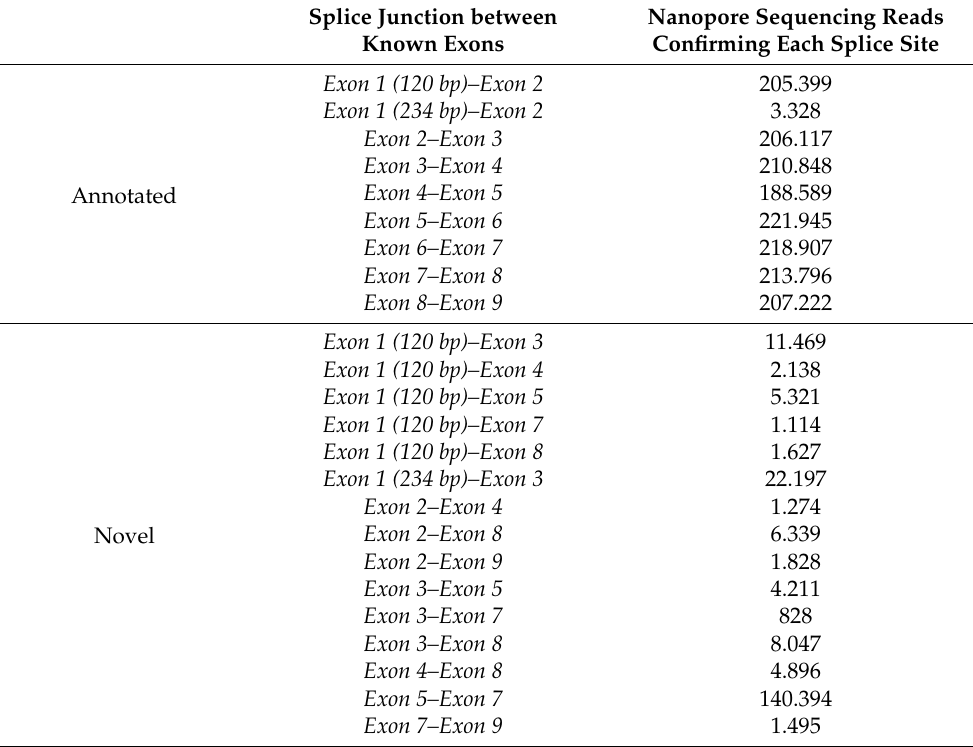
Table 1. List of annotated and novel splice junctions that were detected, as well as the number of nanopore sequencing reads covering, thus verifying each junction.